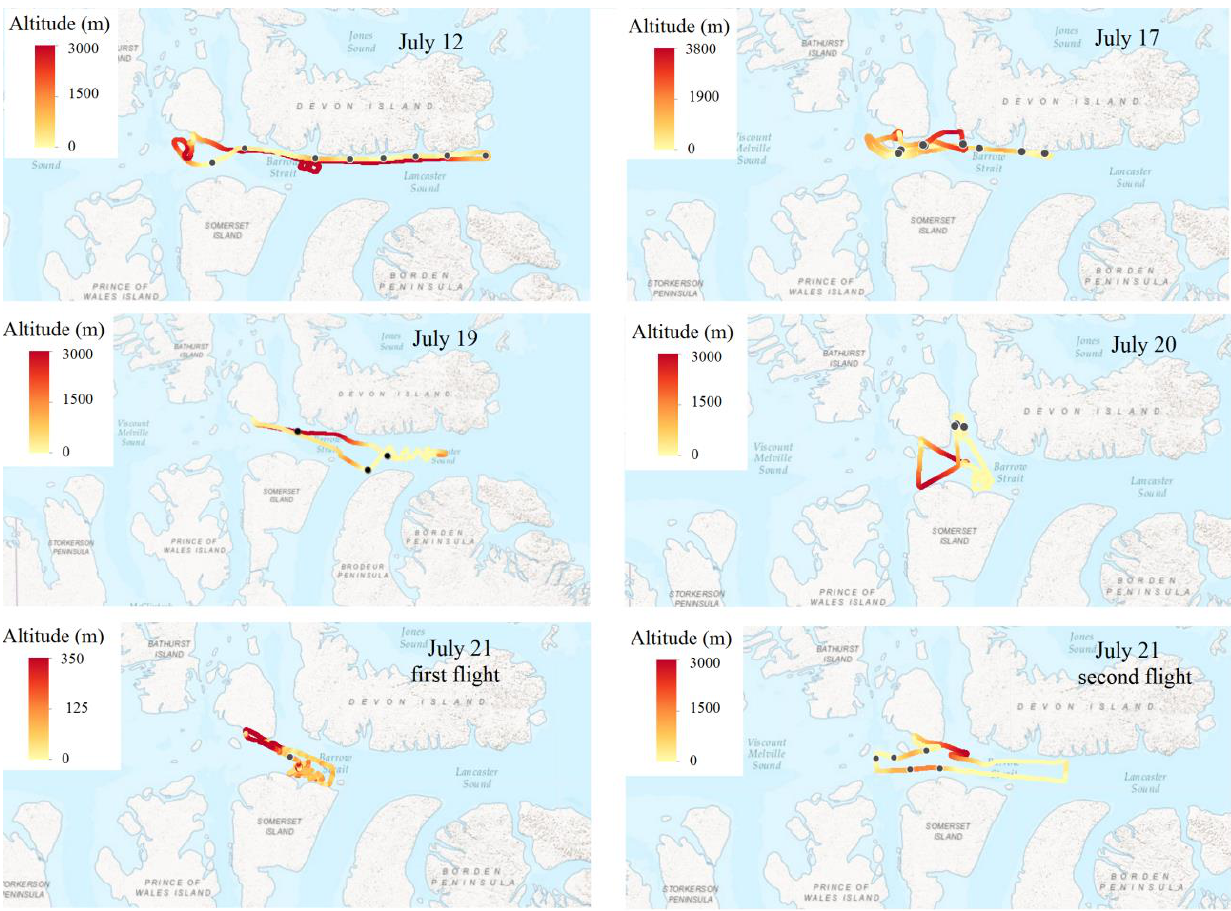
Figure 1. Polar 6 aircraft routes from 12 to 21 July 2014. Colour bars indicate altitudes, and sampling locations are shown with black